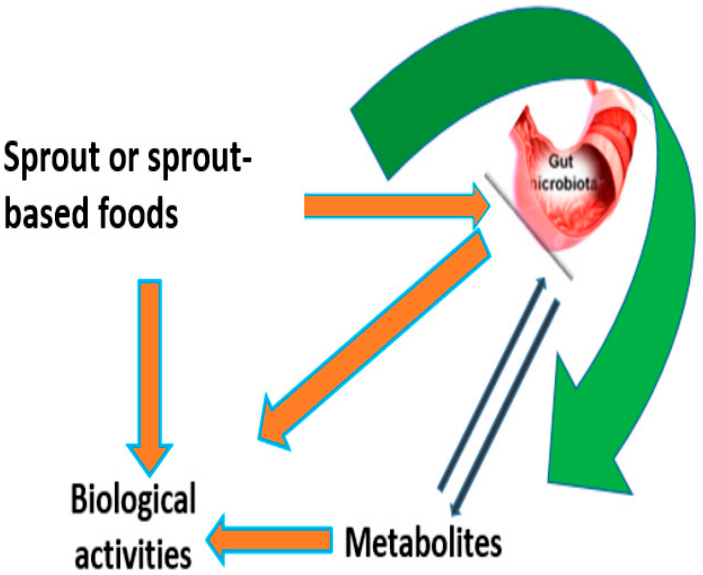
Figure 3. Interaction between secondary metabolites and gut microbiota. When sprout-based foods containing bioactive metabolites are ingested, the microbial ecosystems within the gut rapidly change their functionality in response to the dietary changes [168]. The metabolites are often transformed by the gut microbes before absorption [168]. This transformation modulates their biological activity.